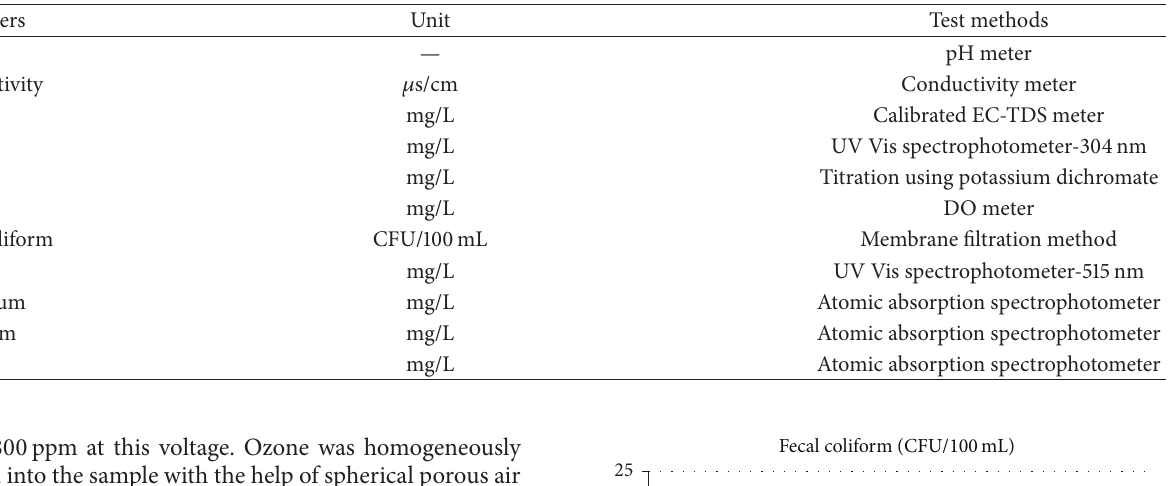
Table 1: Test parameters and their test methods.